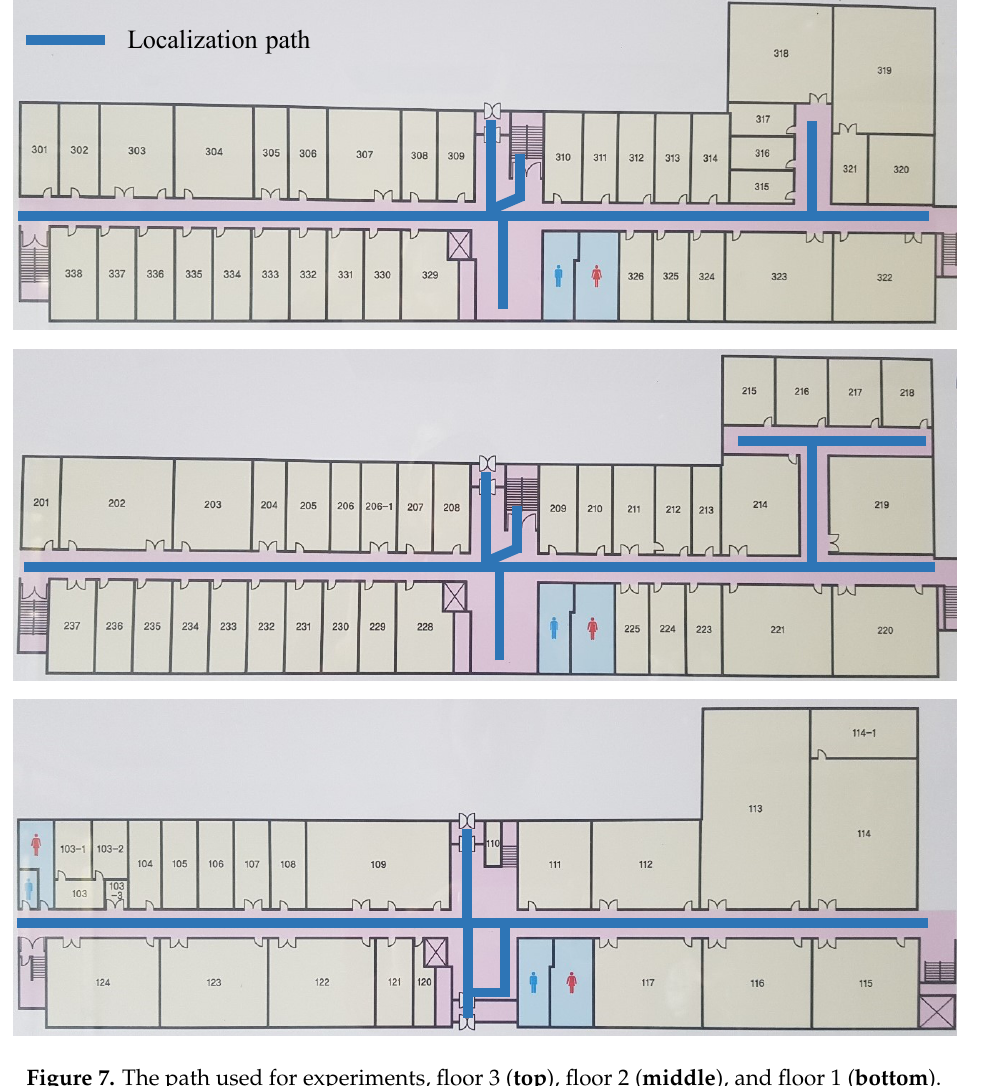
Figure 7. The path used for experiments, floor 3 ( top ), floor 2 ( middle ), and floor 1 ( bottom